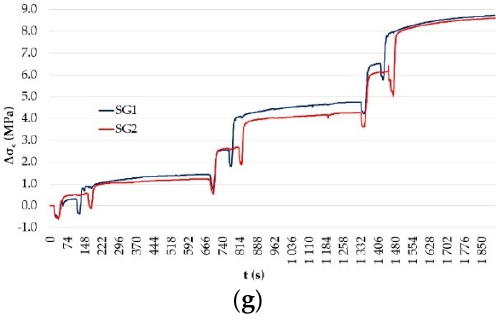
Figure 11. Recorded stress relief in specimens. 1 ( a ); 2 ( b ); 3 ( c ); 4 ( d ); 5 ( e ); 6 ( f ); 7 ( g ).